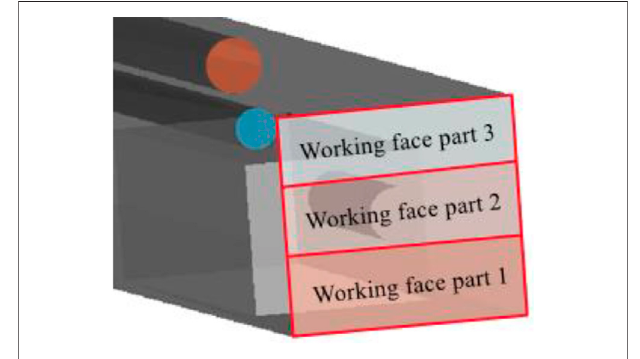
FIGURE 3 | Different positions of dust production at the tunneling head.